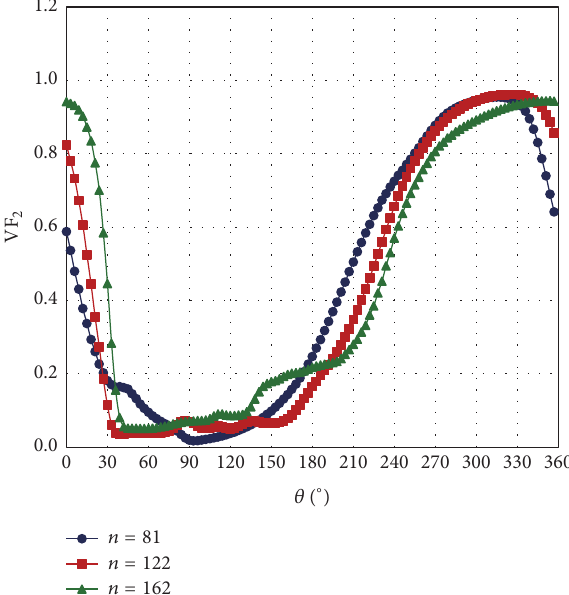
Figure 14: Volume fraction of water at runner outlet